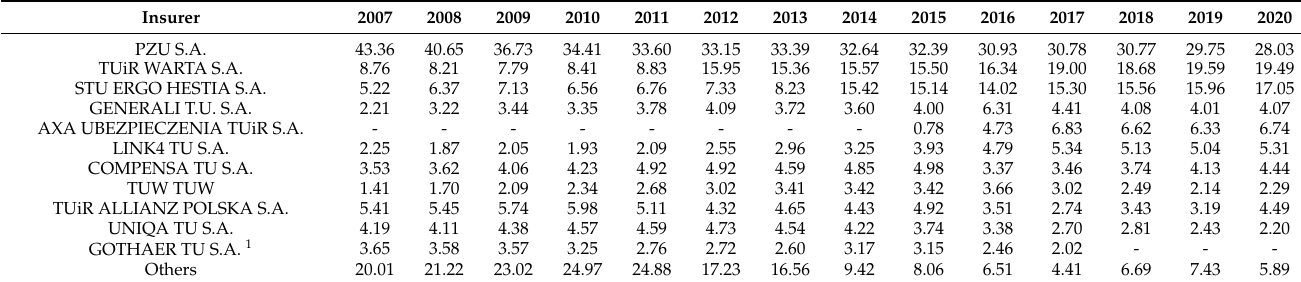
Table 1. The share of individual insurers in the MTPL market between 2007 and 2020 (in %; UKNF 2021).